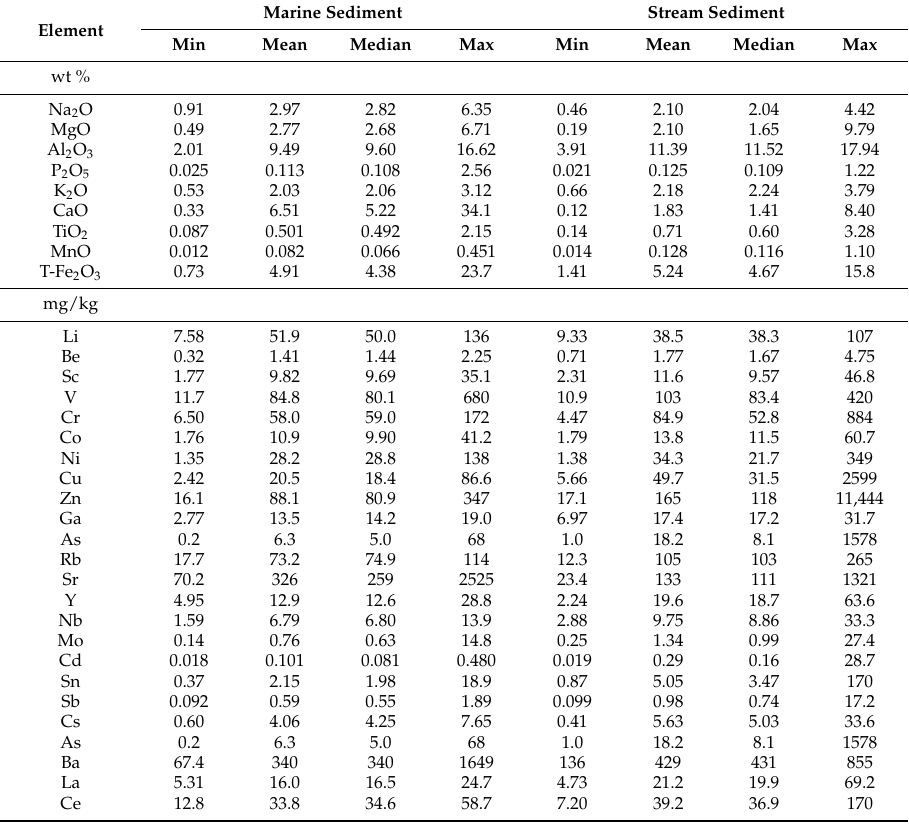
Table 2. Summary for the geochemistry of marine sediments ( n = 463) and stream sediments ( n = 576). Marine Element